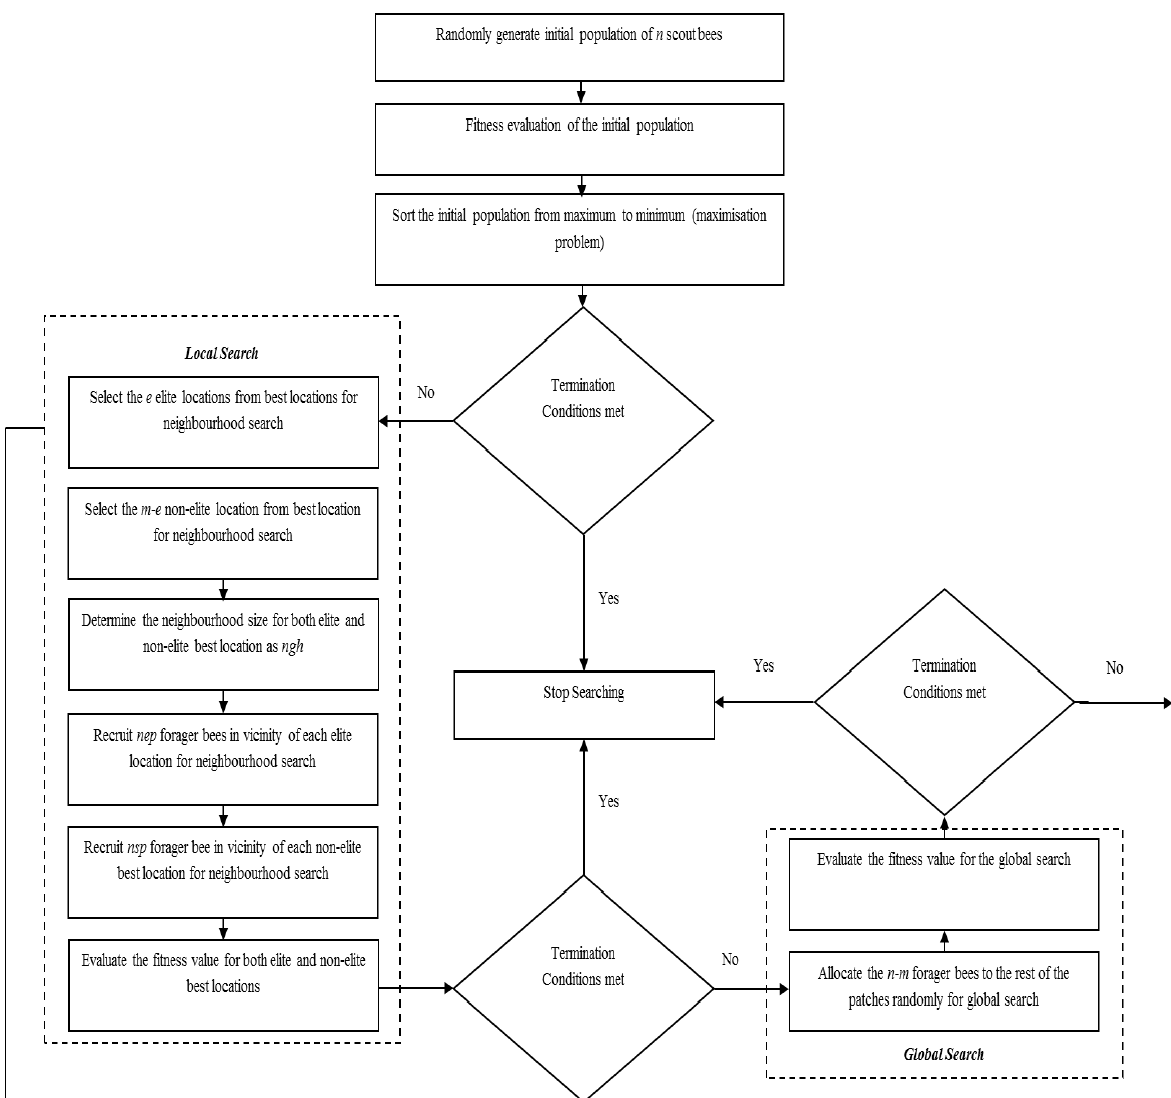
Figure 3. Flowchart of the basic Bees